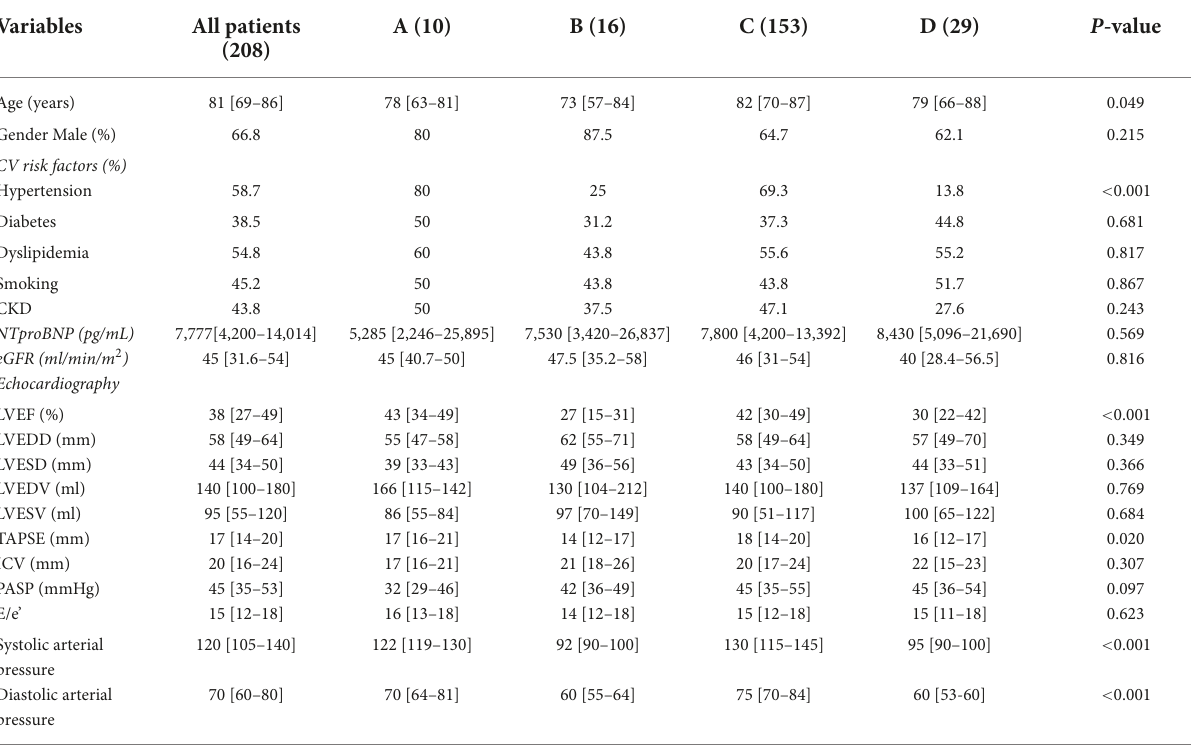
TABLE 1 Demographic, clinical, and echocardiographic differences among warm/cold and wet/dry groups. AHF patients presentation phenotypes (no. of patients)